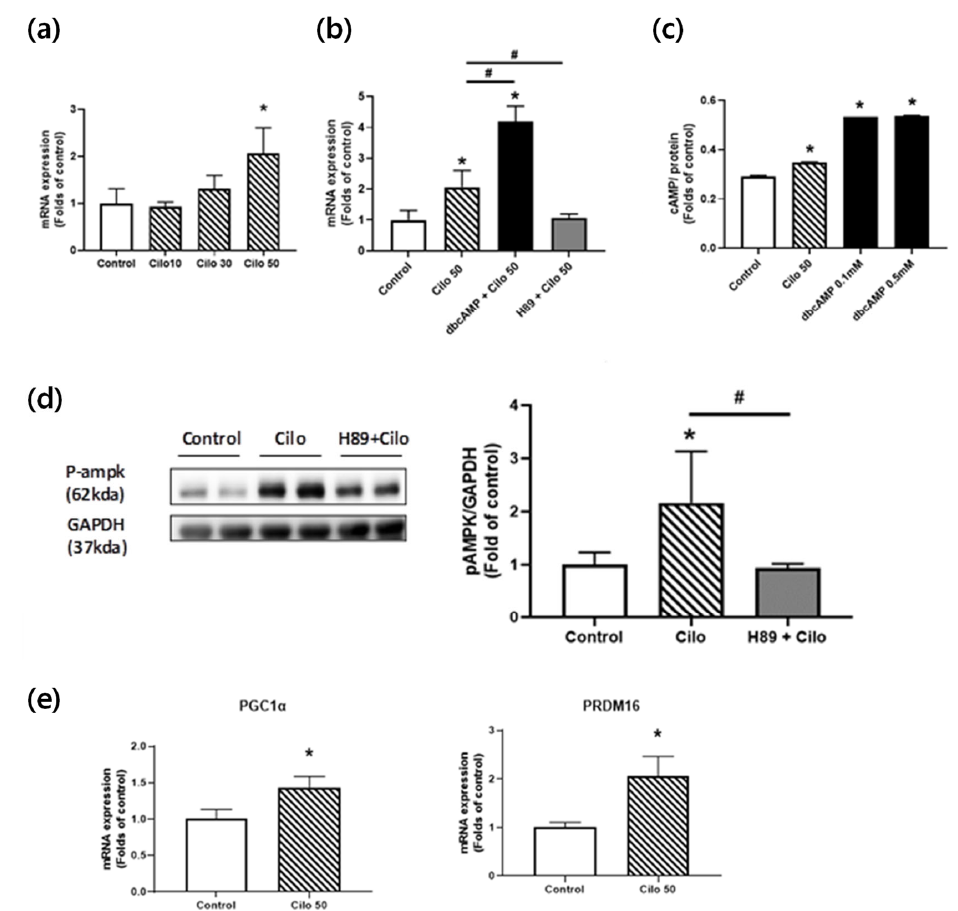
Figure 4. Cilostazol treatment-induced white-to-beige phenotypic conversion in 3T3-L1 cells. ( a ) RT–PCR analysis of vehicle- or cilostazol-treated 3T3-L1 cells for UCP1 transcripts ( n = 5 experiments); ( b ) RT–PCR analysis of UCP1 in 3T3-L1 adipocytes after cilostazol treatment with dbcAMP (0.1 nM) or PKA inhibition by H89 (10 µ M); ( c ) cAMP levels in vehicle-, cilostazol-, and dbcAMP-treated 3T3-L1 cells; ( d ) protein levels phosphorylated AMP-activated protein kinase (pAMPK) in 3T3-L1 cells were determined using Western blot analysis. The graph on the right shows the densitometric analysis of the pAMPK/glyceraldehyde-3-phosphate dehydrogenase (GAPDH) ratio determined from the immunoblots shown on the left. Left, vehicle-treated 3T3-L1 adipocytes. Middle, cilostazol-treated 3T3-L1 adipocytes. Right, cilostazol- and H89-treated 3T3-L1 adipocytes; and ( e ) RT–PCR analysis of vehicle- or cilostazol-treated 3T3-L1 cells for PGC-1 α and PRDM16 transcripts ( n = 5 experiments). * p < 0.05 vs. corresponding control value and # p < 0.05 vs. corresponding cilostazol-treated 3T3-L1 adipocytes value. Cilo,